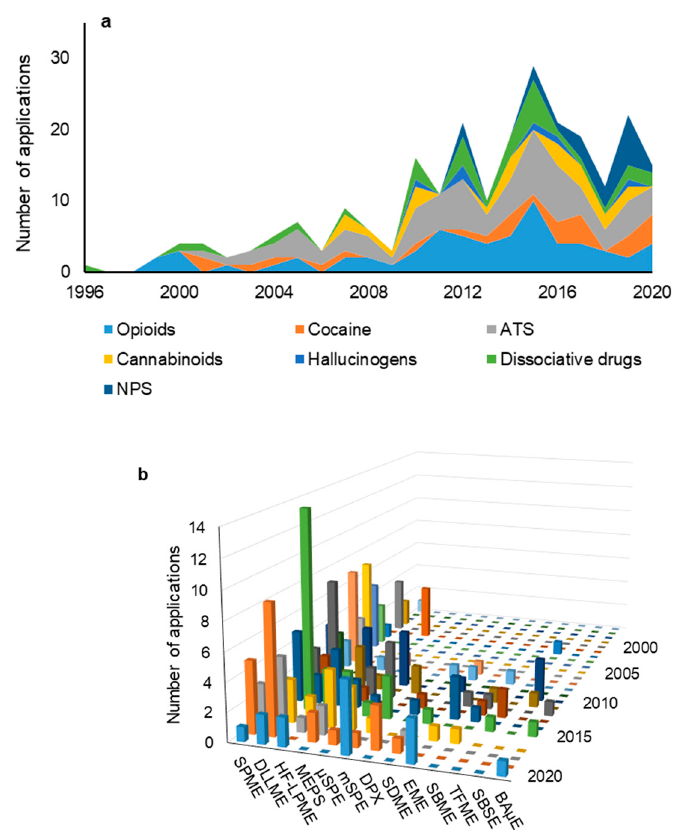
Figure 1. Number of applications for screening-controlled drugs in forensic matrices over the last quarter of century sorted by the type of priority substances ( a ) and microextraction-based techniques ( b ). The data reported for 2020 only includes published articles until the end of June.